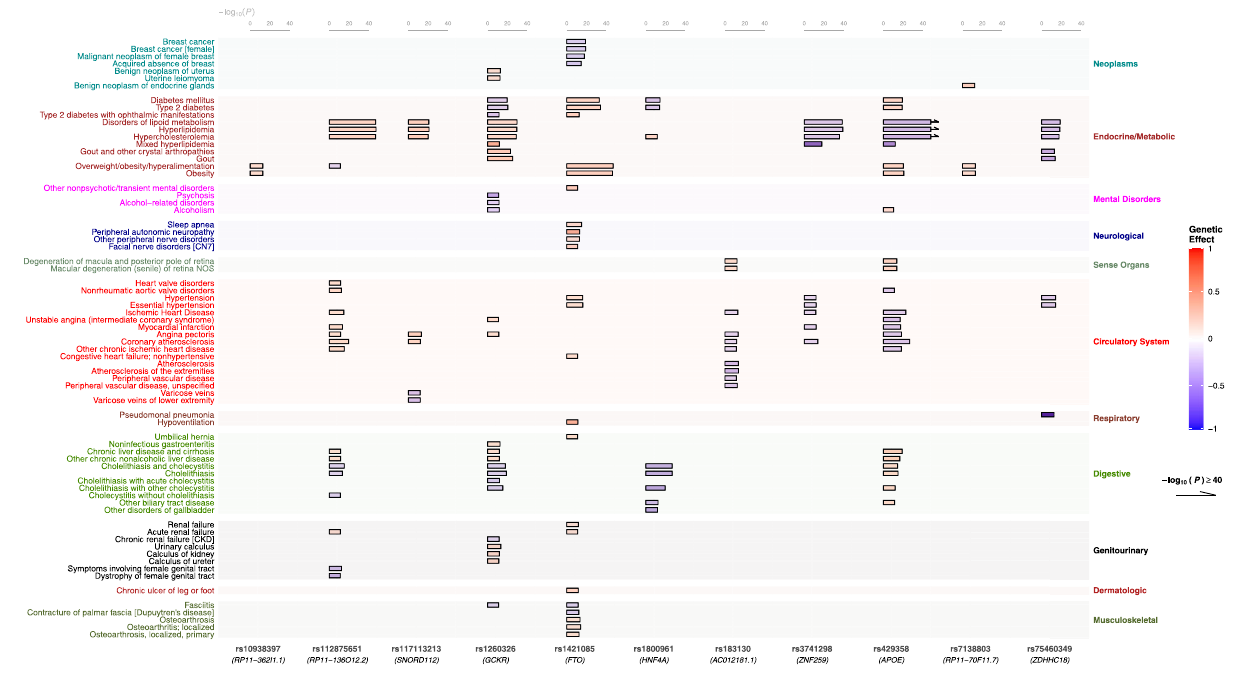
Fig. 4 | Highlighted PheWAS results (FDR signi fi cant) in UK Biobank for the 12 colocalized SNPs with a discordant direction of effect between C-reactive protein levels and any of the other examined traits. The color of each bar representsthegeneticeffectsizefortherespectiveSNPwhilethelengthofeachbar showsthe statisticalsigni fi canceon the − log 10 P scale. The variant rs429358 ( APOE )